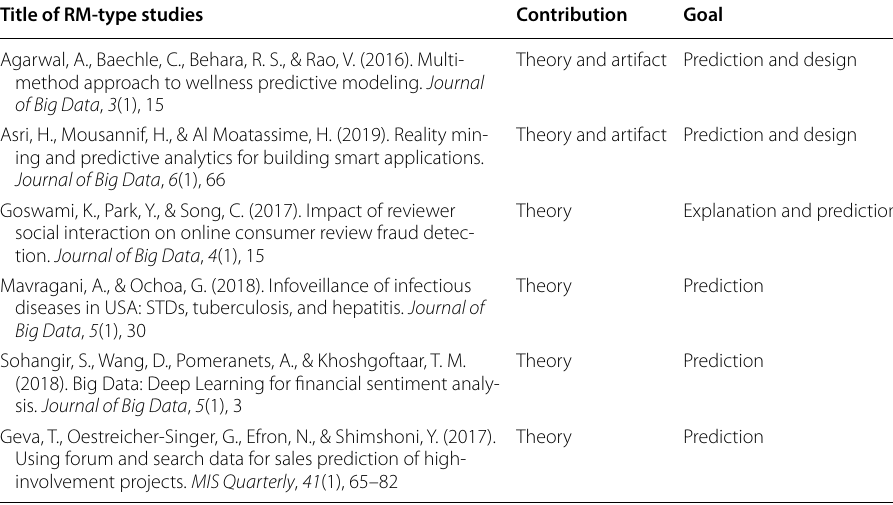
Table 6 Sample of studies using data science as a research